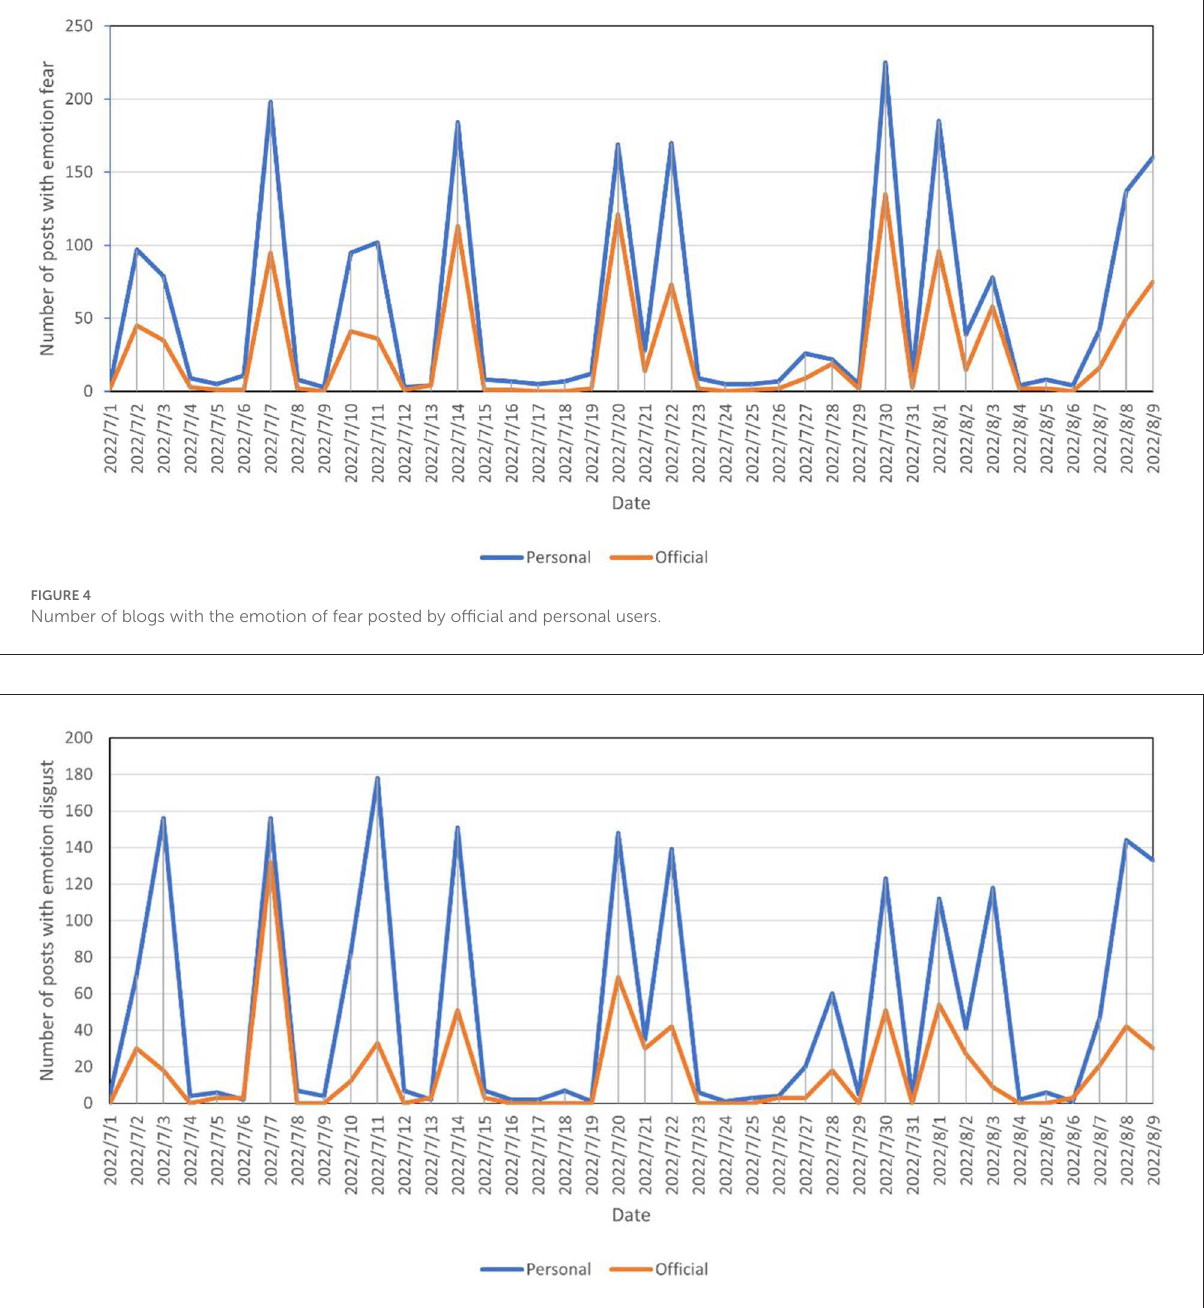
FIGURE5 Number of blogs with the emotion of disgust posted by official and personal